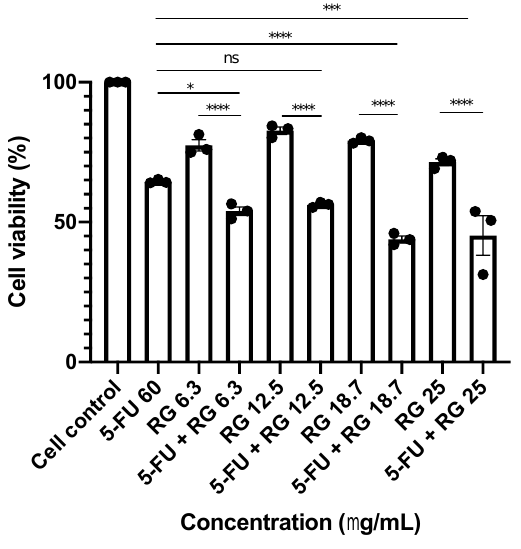
Figure 5. Effect combination of 5-FU and red ginger (RG) extract in WiDr cells at 48h incubation. Cells were treated 5-FU at concentrations of 60μg/mL, and in combination with red ginger extract with various values of red ginger extract, such as 6.3, 12.5, 18.7, and 25μg/mL. Percentage of cell viability was expressed as mean ± SD. Statistical analysis used One-way Anova and the Tuckey’s range test. * p value